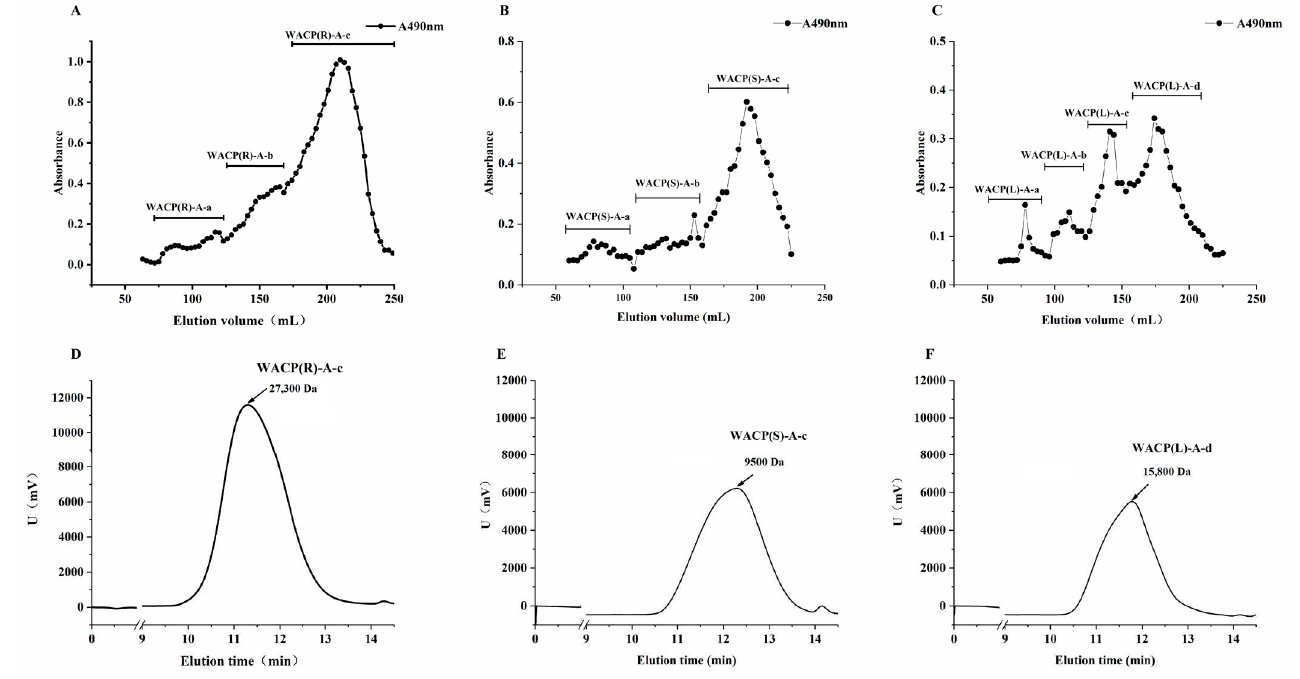
Figure 3. Purification of the pectic polysaccharide fractions ( A : WACP(R)-A, B : WACP(S)-A, C : WACP(L)-A) from Aralia continentalis and analysis by HPGPC ( D : WACP(R)-A-c, E : WACP(S)-A-c, F : WACP(L)-A-d). Table 3. Monosaccharide composition of three purified polysaccharide fractions from the acidic polysaccharides of Aralia continentalis .